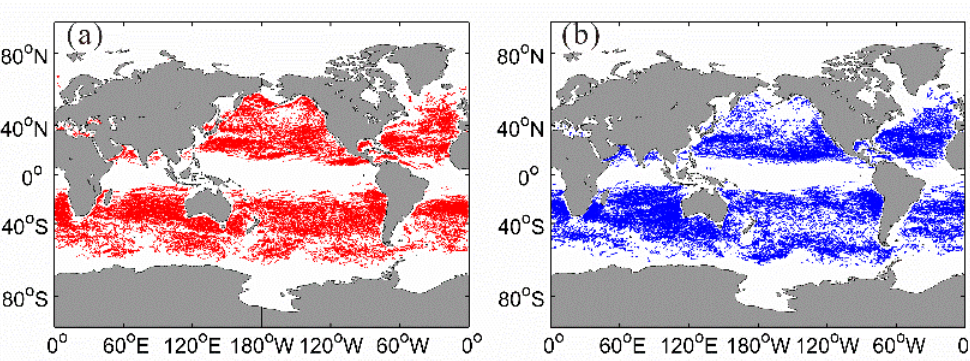
Figure 3. Geographical distribution of long-lived (longer than 16 weeks) ( a ) Anticyclonic and ( b ) Cyclonic eddytracks identifiedusing the hybrid method over a period of 23 years from 1993 to 2015.